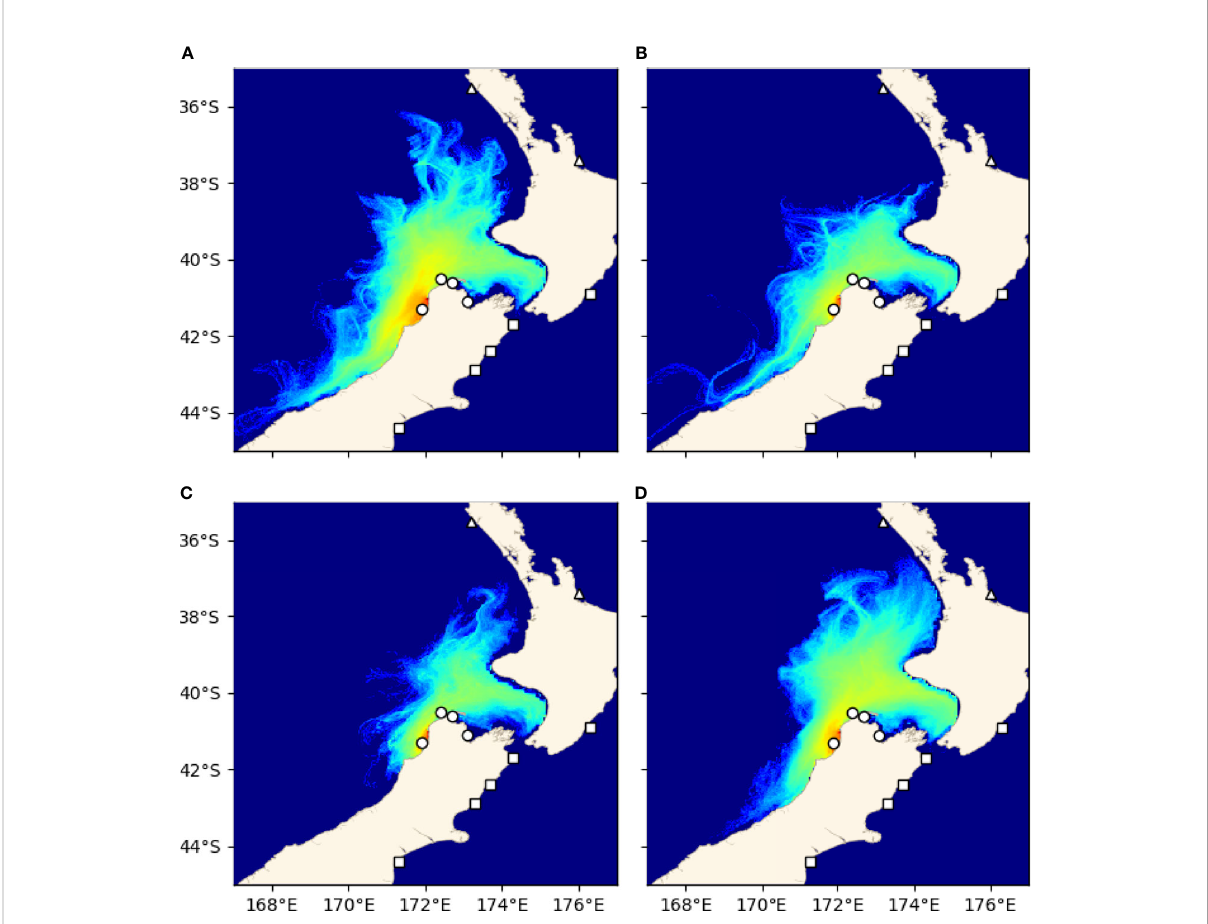
FIGURE 7 Seasonal variation of probability densities of trajectories from Little Wanganui River. (A) Summer (Jan-Mar), (B) autumn (Apr-Jun), (C) winter (Jul-Sep), (D) spring